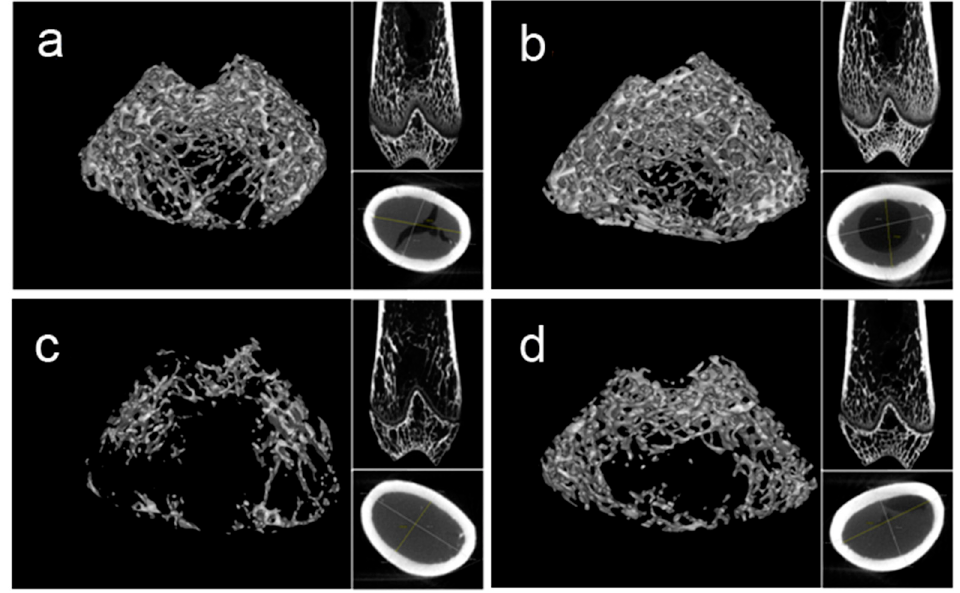
Figure 2. Representative three-dimensional images of trabecular bone within the distal femoral metaphyseal region in various treatment groups: ( a ) baseline; ( b ) control; ( c ) HLU; and ( d ) HLU–DRTF.